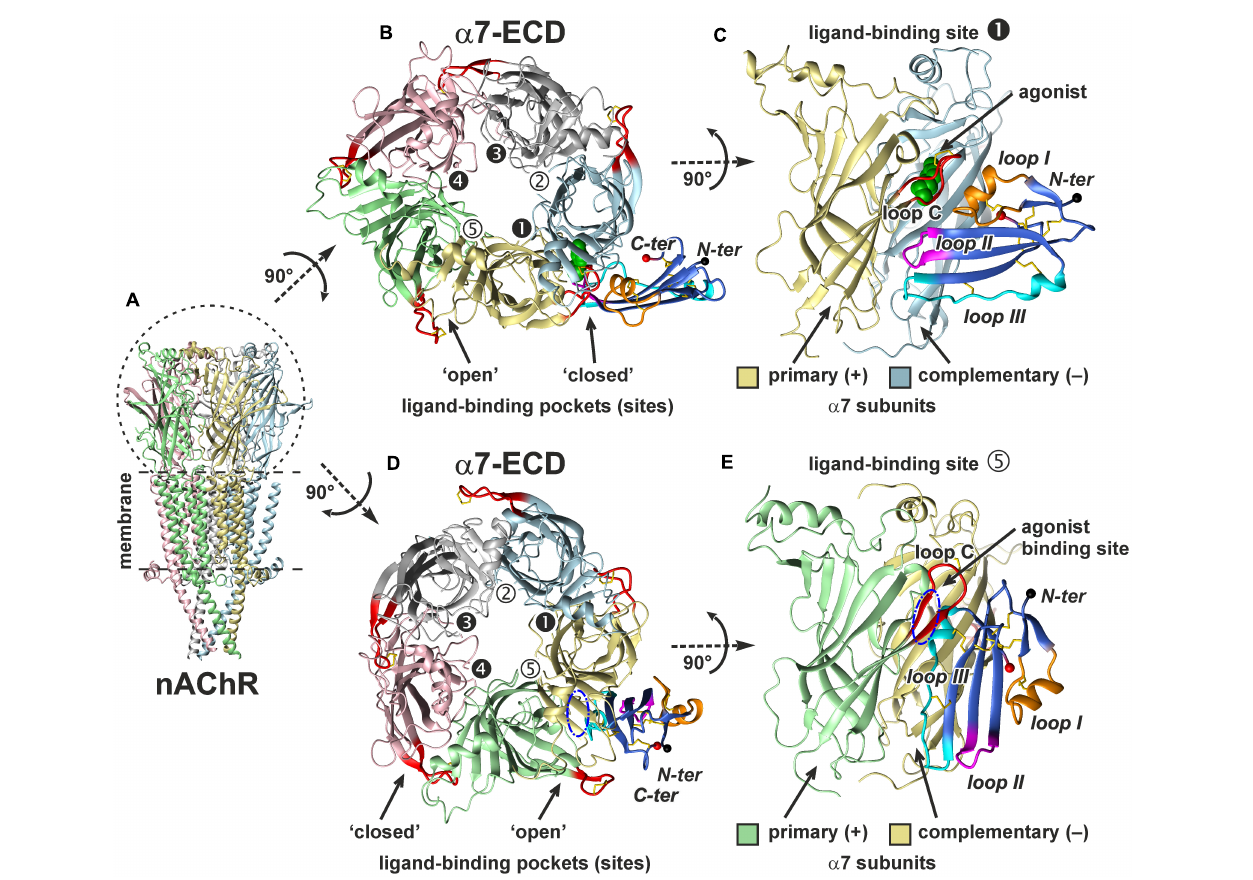
FIGURE 8 | In silico modeling of the α 7-ECD/ws-Lypd6 complex. (A) General view of homopentameric nAChR in the membrane. For clarity, the subunits are colored differently. (B,D) The top view on α 7-ECD with the bound ws-Lypd6 molecules. Ligand-binding sites of the receptor have different conformations of the loop C. In the sites 1, 3, and 4 the ligand-binding pockets are “closed” by the loop C, while in the sites 2 and 5 the ligand-binding pockets are “open”. (C,E) The side view on the ligand-binding sites 1 and 5 of α 7-ECD. Each binding site is formed at the interface between the primary (+) and complementary (–) α 7 subunits. (B,C) Representative solution, where ws-Lypd6 contacts the “closed” α 7-nAChR binding site with the loops I, II and III (complex #1, Supplementary Table 1 ). For clarity, the agonist (epibatidine) molecule (green spheres) is placed into the orthosteric ligand-binding site according to PDB id 3SQ6. (D,E) Representative solution, where ws-Lypd6 interacts with the “open” α 7-nAChR binding site by the “head” and loop III (complex #2, Supplementary Table 1 ). The putative position of an agonist in the orthosteric binding site is shown by blue dashed-dot ellipses. C loop of the primary α 7 subunit and ws-Lypd6 loops are shown by red and orange/magenta/blue colors, respectively. Disulfide bonds are in yellow. N - and C -termini of the Lypd6 LU-domain are shown with black and red spheres, respectively. The “favorable” contacts observed in the complexes are listed in Supplementary Table 1 .